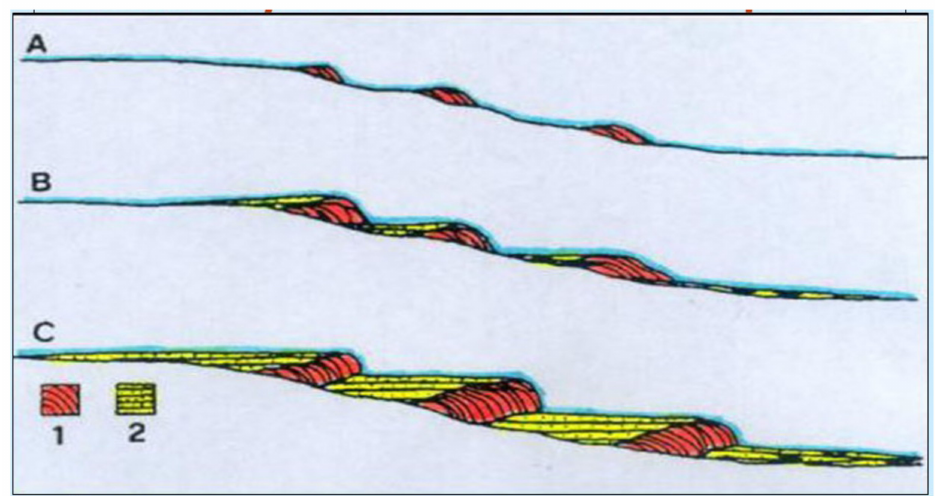
Figure 6. Evolutionary scheme (from initial phase A to final phase C) of tufa dams and backside pools along a watercourse: 1. phytohermal tufa; 2. stromatolithic and phytoclastic tufa.